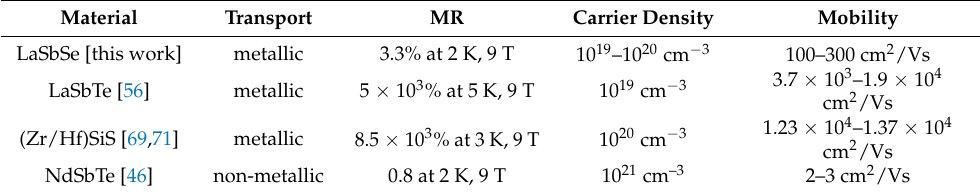
Table 3. A comparison of electronic properties of LaSbSe with other ZrSiS-family